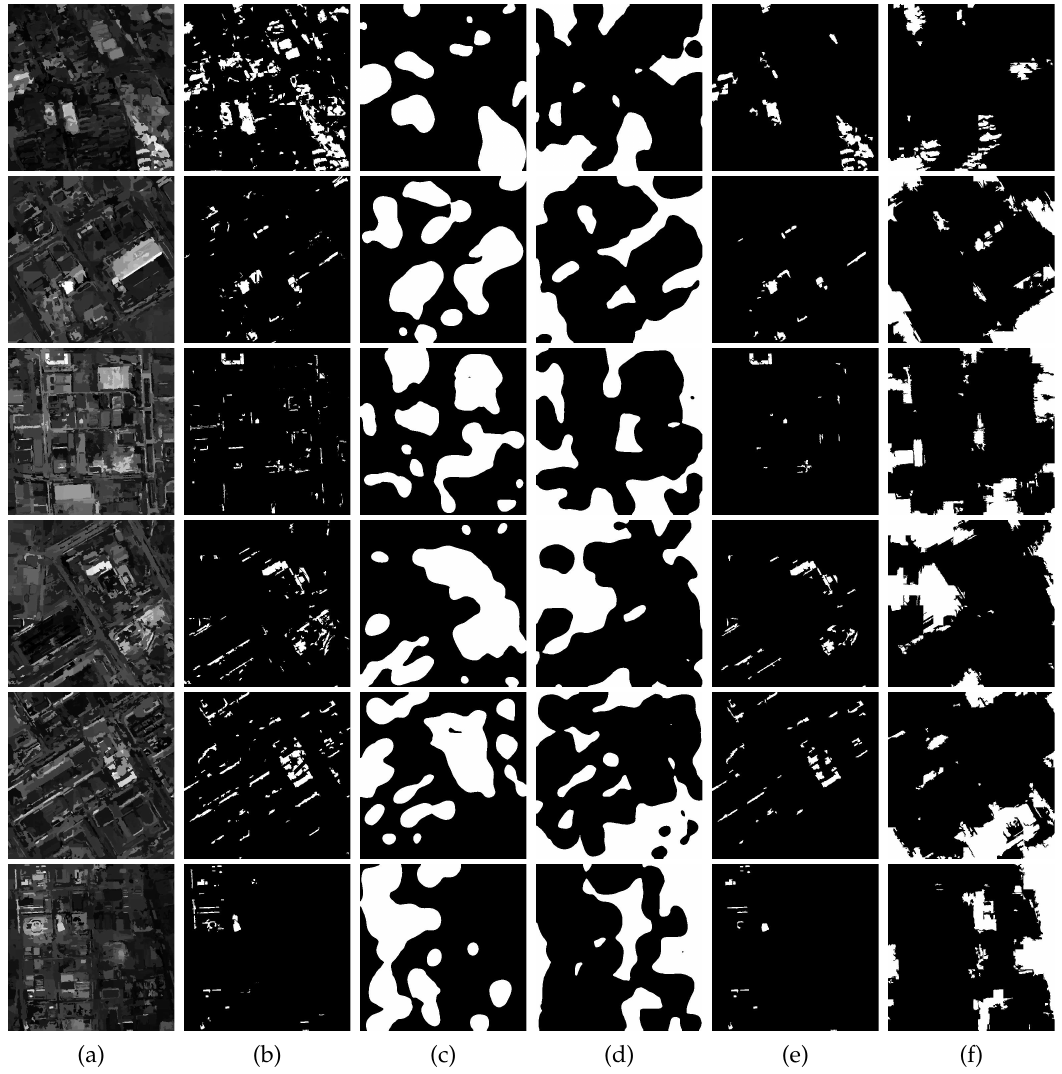
Figure 9. Intermediate results of MBI and saliency. From up to down: corresponding results of the aforementioned two data sets. (a) The difference image by object-based CVA . (b) Building regions by thresholding MBI. (c) Salient regions. (d) Non-salient regions. (e) Changed objects of training sets. (f) Unchanged objects of training sets.